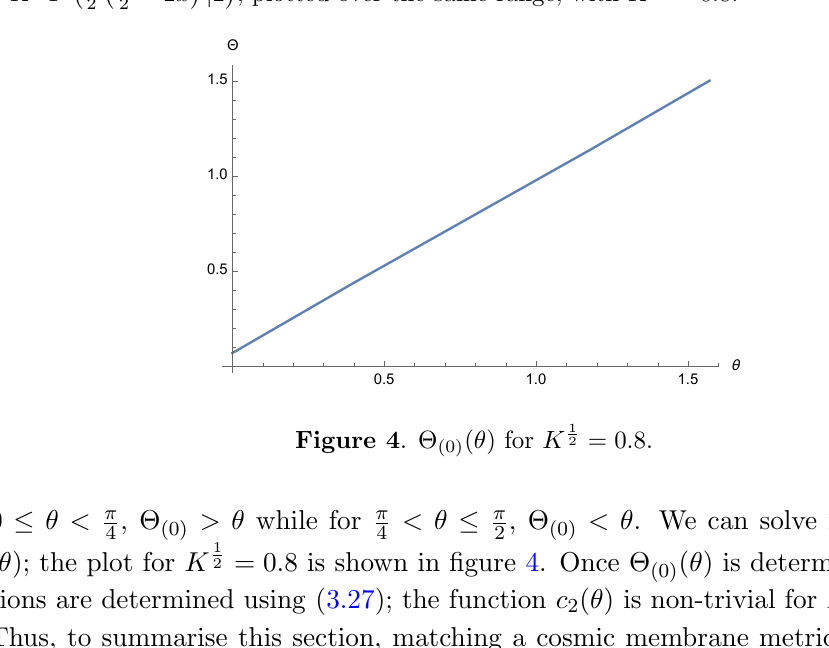
Figure 3 . The blue line shows F shows K 1 2 F